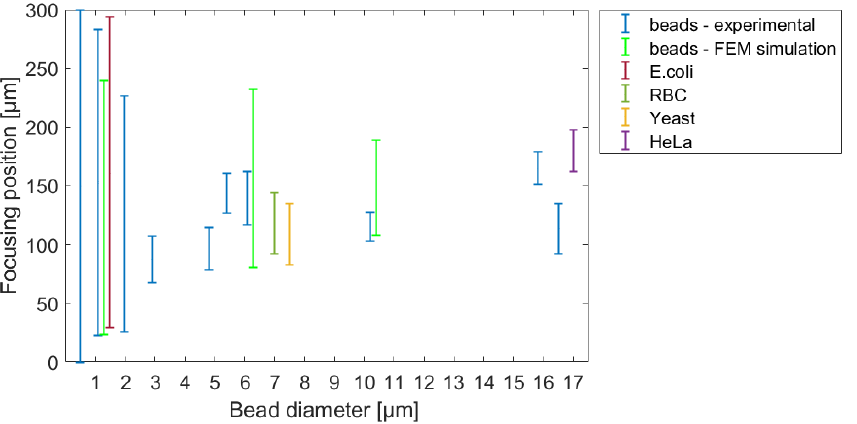
Figure 7. The focusing positions and concentration ranges of rigid beads and target cells in the applied lateral-focusing microfluidic system (projected to a demonstrative 300 μ m wide channel cross-section). The modelled probable focusing ranges are also indicated in the case of bead diameters of 1.1 µm, 6.8 µm, and 10.2 µm, respectively.